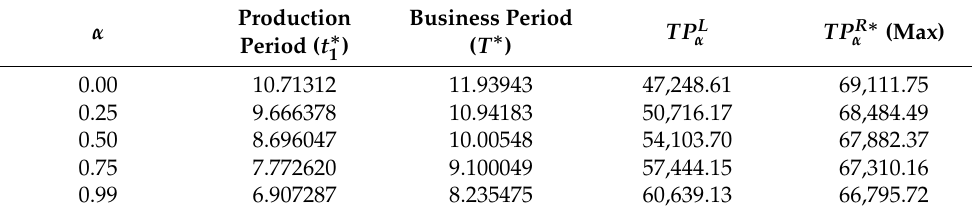
Table 6. Optimum results of Example 2 for maximizing TP R α